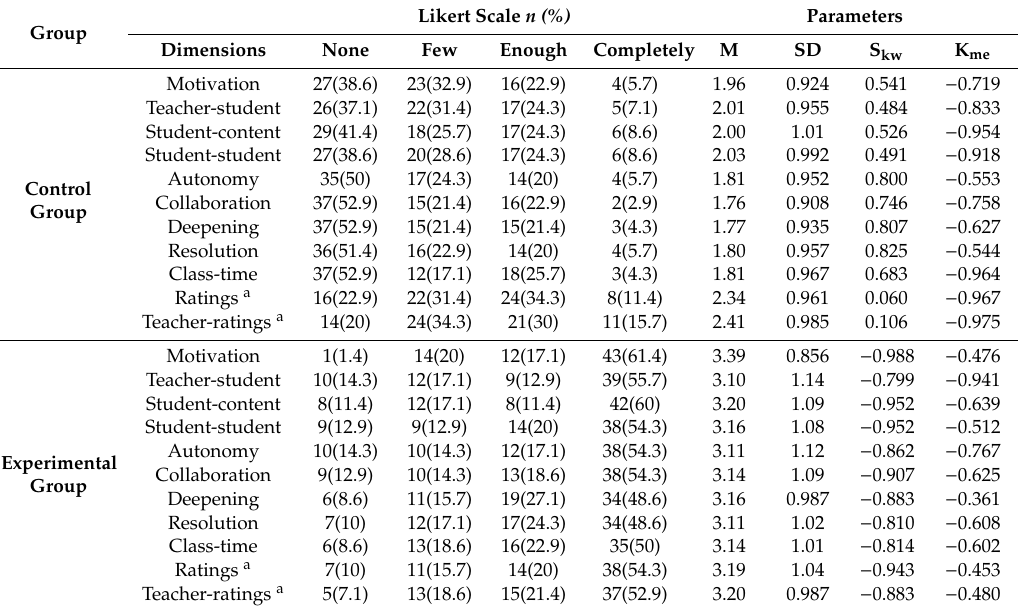
Table 3. Results obtained for the dimensions of study in the control group and experimental group of Higher